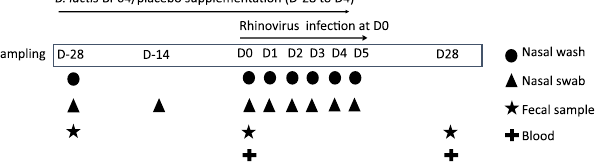
Figure 1. Study outline and sampling set-up. Subjects were enrolled from three separate cohorts to receive either Bl-04 (2 × 10 9 CFU/day) or placebo for 28 days prior to being challenged with an experimental rhinovirus. The participants continued investigational product intake for 4 days post-challenge. On study day (D) 0, subjects were inoculated with rhinovirus type A39 (FDA-BB-IND #12934) (100 TCID 50 , split between both nostrils). On D1– time at D28 for collection of convalescent serum for antibody to rhinovirus type